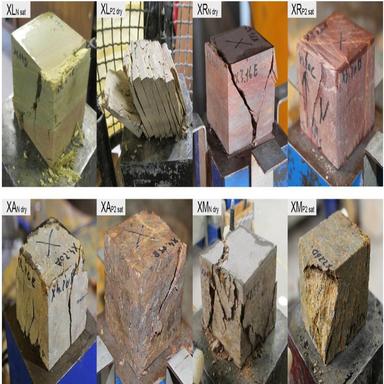
Examples of schist specimens tested under dry mass and saturated conditions, exhibiting the most observed types of failures.